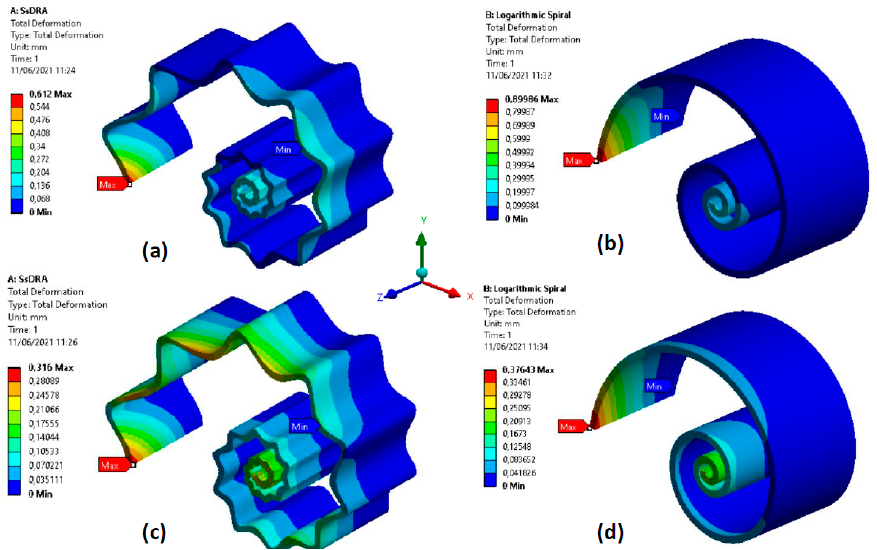
Figure A4. A comparison of the flexural stiffnesses of the SsDRA and LsDRA in cantilever configu- ration: ( a ) and ( b ) deformations under a load corresponding to Fx = 200 N; Fy = Fz = 0; ( c ) and ( d ) deformations under a load corresponding to Fy = − 200 N; Fx = Fz = 0.